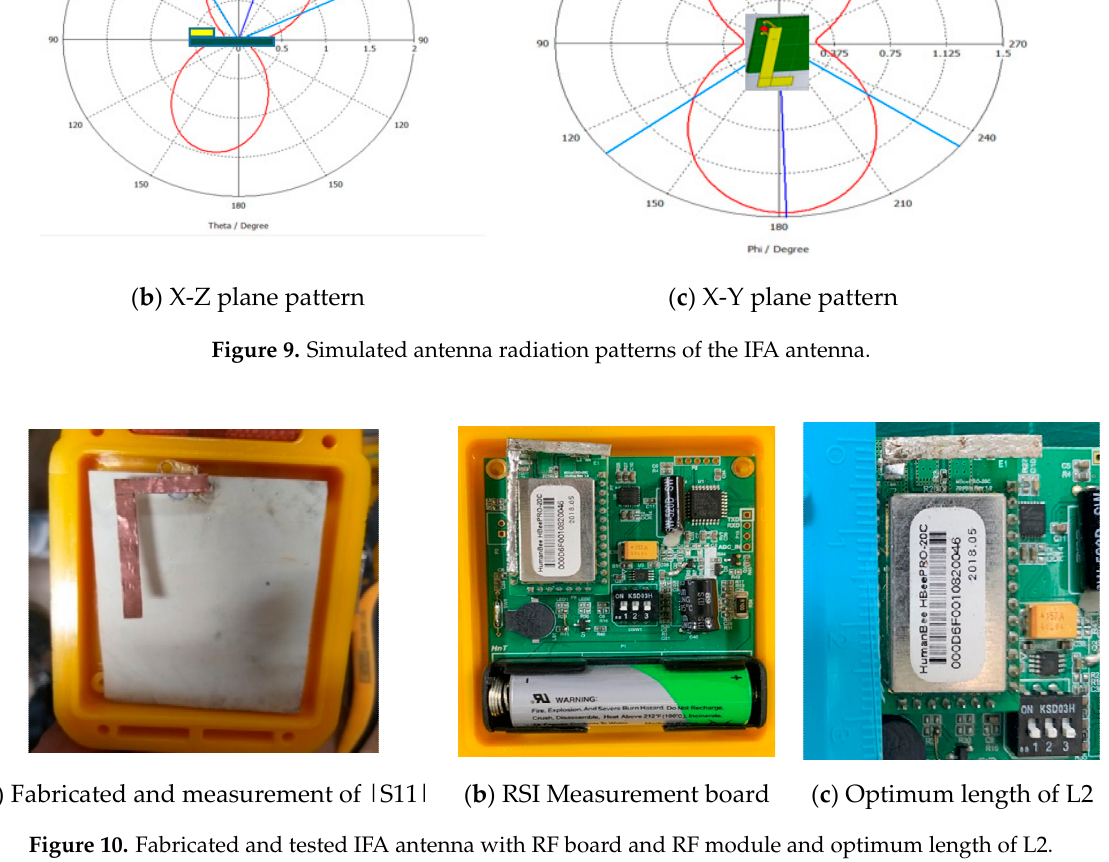
Table 1. Comparison of signal strength measurement with chip antenna and proposed IFA an- tenna.